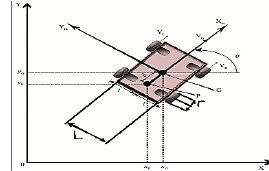
Fig. 1. Four-wheel mobile differential drive robot posture